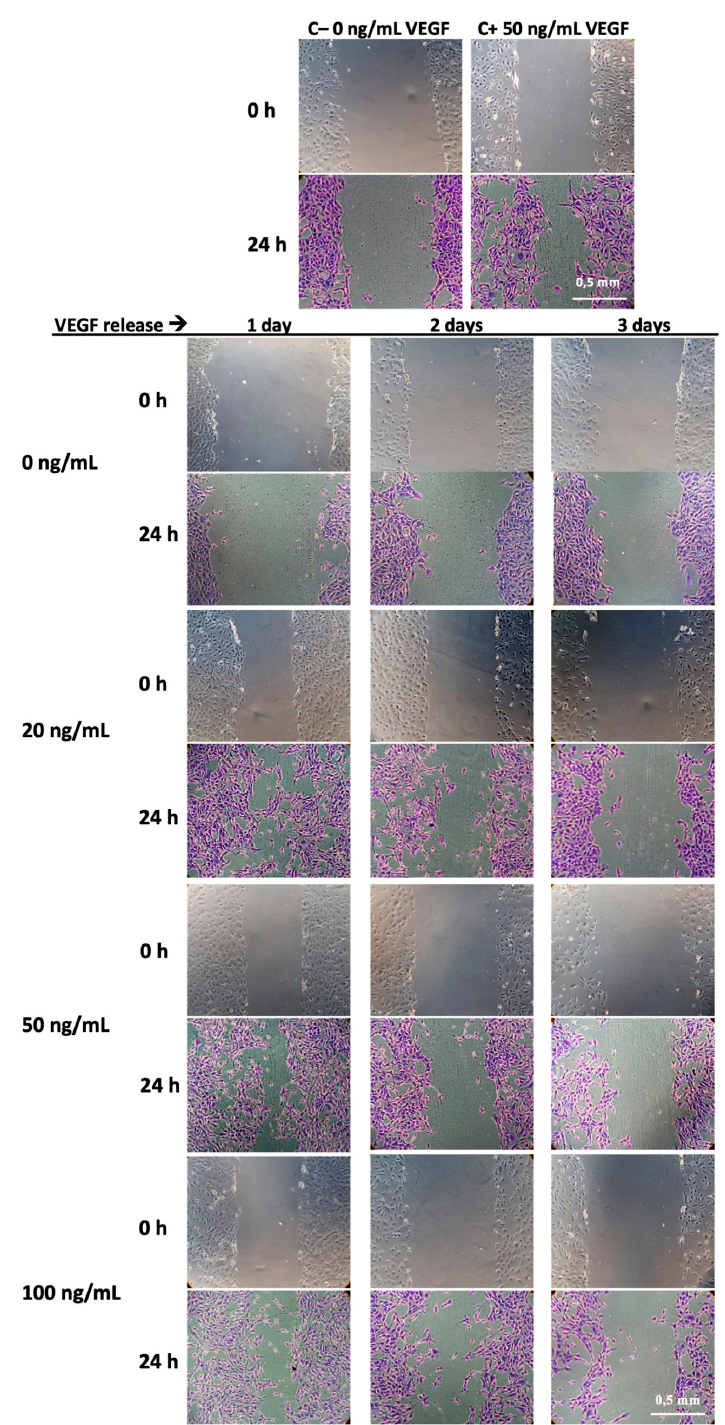
Figure 9. Representative images of “wound” shape in scratch wound migration assay, with HUVECs cell cultured in the VEGF release medium collected from 3-day release test of different VEGF-loaded sponges (0, 20, 50, and 100 ng VEGF/scaffold). The images represent the wound shape at its creation (0 h) and the healing by migration of HUVECs cells after 24 h. The test was repeated twice and each in duplicate ( n = 4).